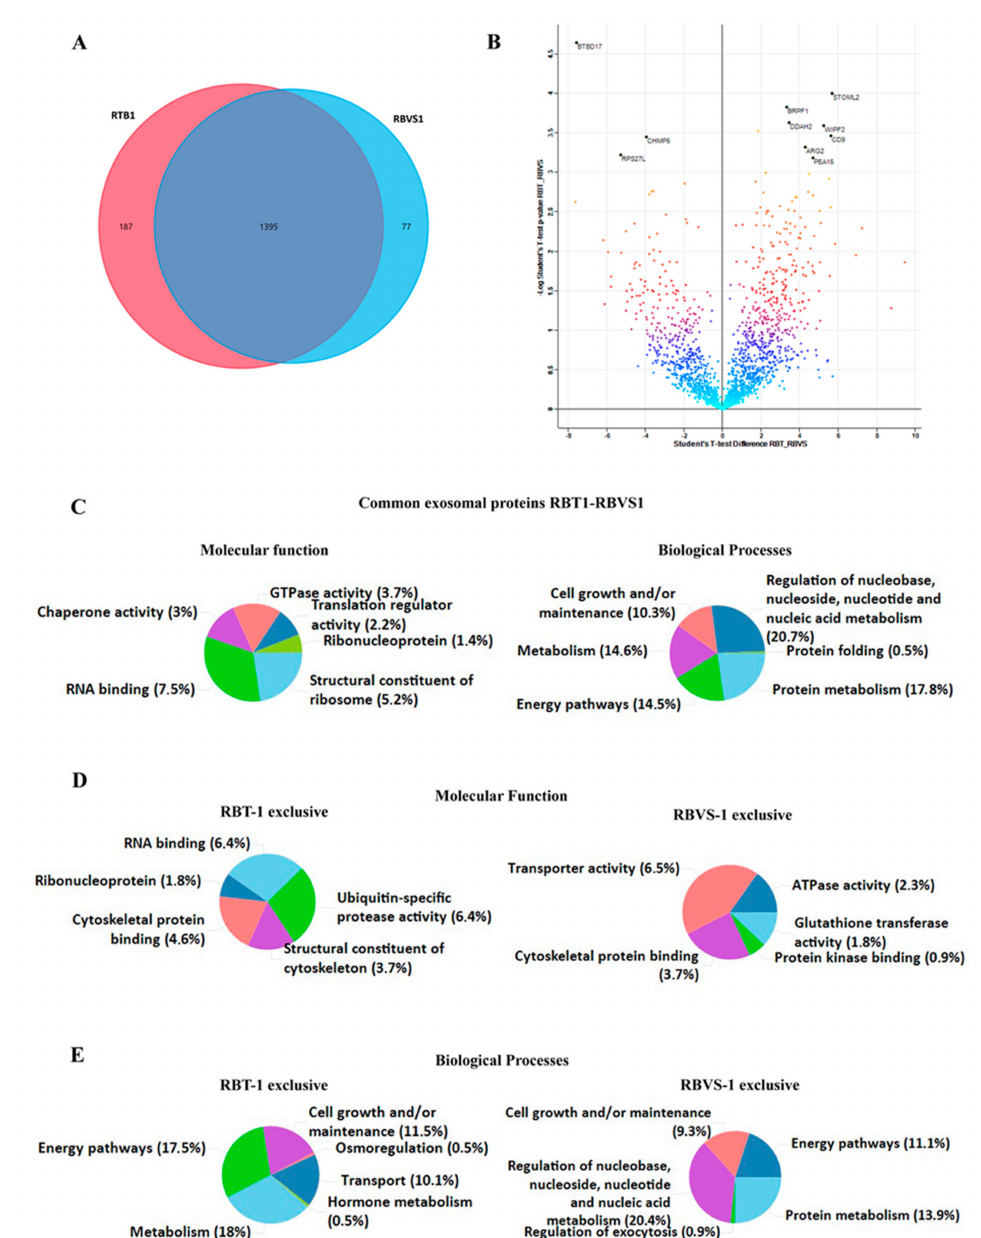
Figure 7. Comparison of proteins di ff erentially expressed between exosomes, derived from RBT and RBVS of the same patient. ( A ) Venn diagram of the total number of detected proteins in RBT1 and RBVS1-derived exosomes. Notably, 187 proteins were exclusively present in RBT1-derived exosomes, while 77 proteins were exclusively present in RBVS1-derived exosomes. Overall, 1395 proteins were shared by the two cell lines. ( B ) The volcano plot illustrates the results of data obtained from the two di ff erent conditions, RBT1 and RBVS1. The proteomes are compared, starting from a value of FDR < 0.05 and S0 > 0.1. Density plot coloration highlights the similarity between the two groups, black dots are the proteins that exceed the acceptability threshold, significantly modulated. ( C ) Graphical representation of the molecular function and biological processes for common exosomal proteins of RBT1 and RBVS1 obtained with FunRich software. ( D ) Graphical representation of molecular function gene enrichment for RBT1 and RBVS1 exclusive proteins. ( E ) Graphical representation of biological processes gene enrichment for RBT1 and RBVS1 exclusive